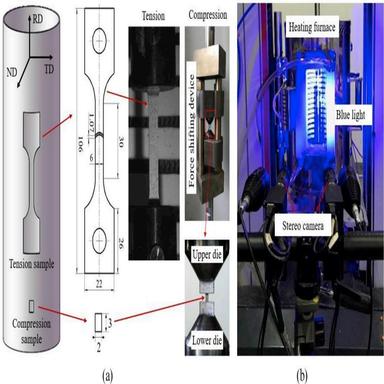
Experimental set-up: (a) tension and compression samples and (b) HT-DIC testing system.